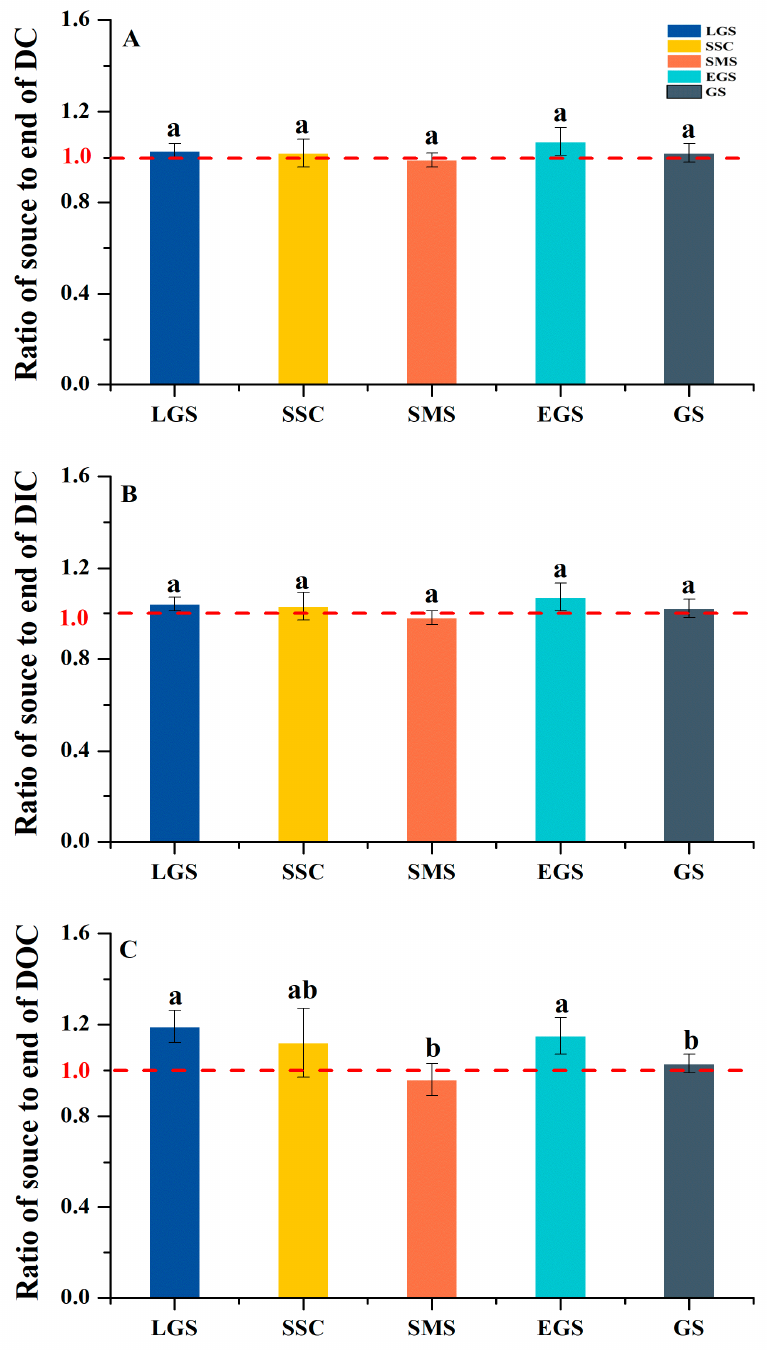
Figure 6. The ratios of dissolved carbon (DC) stocks from source waters to export waters in the subalpine forest streams in the upper reaches of the Yangtze River from 11 July 2015, to 2 August 2016. Total dissolved carbon stock (DC, ( A )); dissolved inorganic carbon stock (DIC, ( B )); dissolved organic carbon stock (DOC, ( C )). LGS, SSC, SMS, EGS, and GS indicate the sampling periods, i.e., the late growing season (LGS: September to October), seasonal snow cover (SSC: November to April of the following year), snowmelt season (SMS: April to May), early growing season (EGS: May to June), and growing season (GS: July to August), respectively. The values of the vertical coordinates are the averaged values for 15 streams in this period, the error bars are the standard deviations of 15 streams during every period. Different lowercase letters indicate significant differences among different periods ( p < 0.05), while the same letter indicates no significant difference among each.